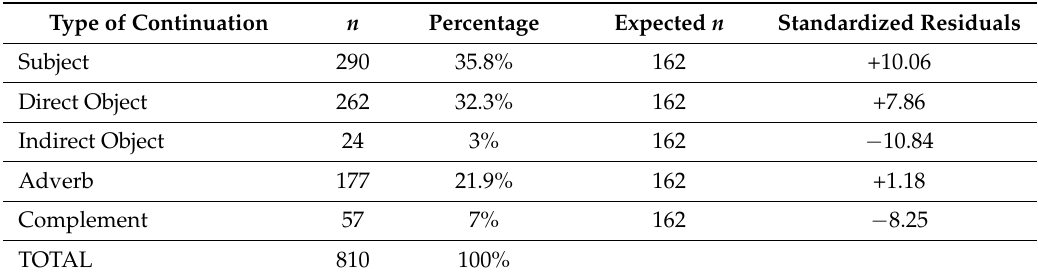
Table 1. Results of the preferred type of continuation in corpus